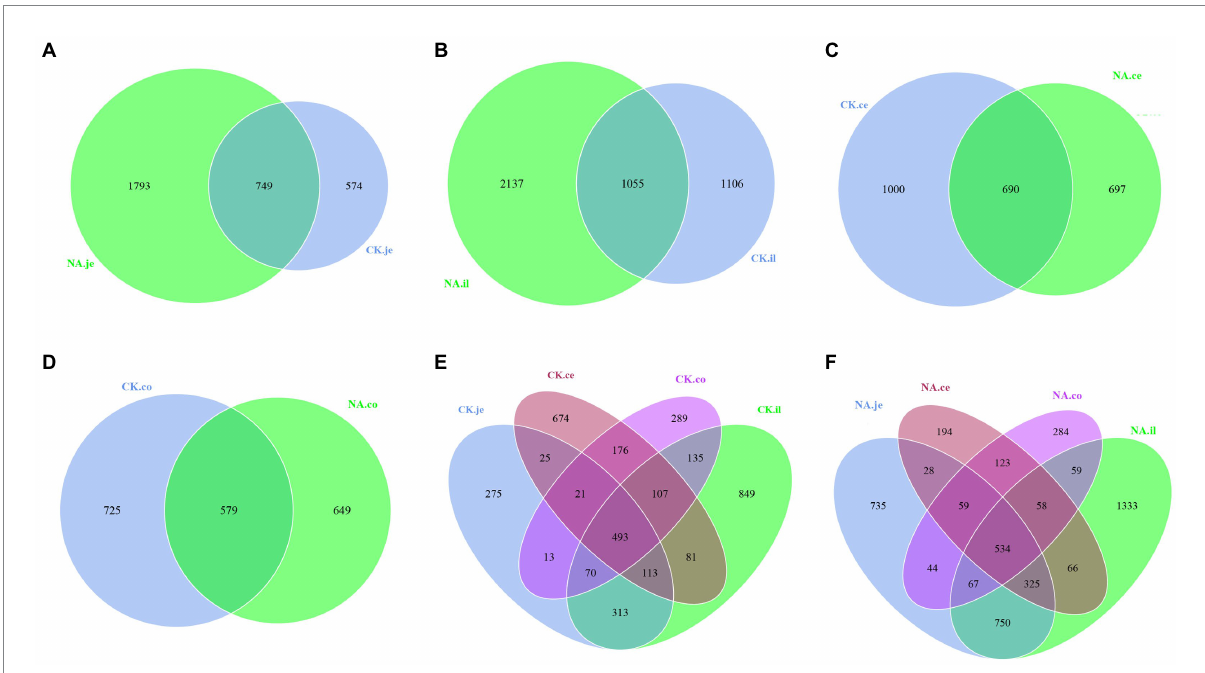
FIGURE 6 Venn diagram based on OTU. (A) The jejunum between CK and NAFLD (NA) groups, (B) the ileum between CK and NAFLD (NA) groups, (C) the cecum between CK and NAFLD (NA) groups, (D) the colon between CK and NAFLD (NA) groups, (E) the jejunum, ileum, cecum, and colon of CK group, and (F) the jejunum, ileum, cecum, and colon of NAFLD (NA)